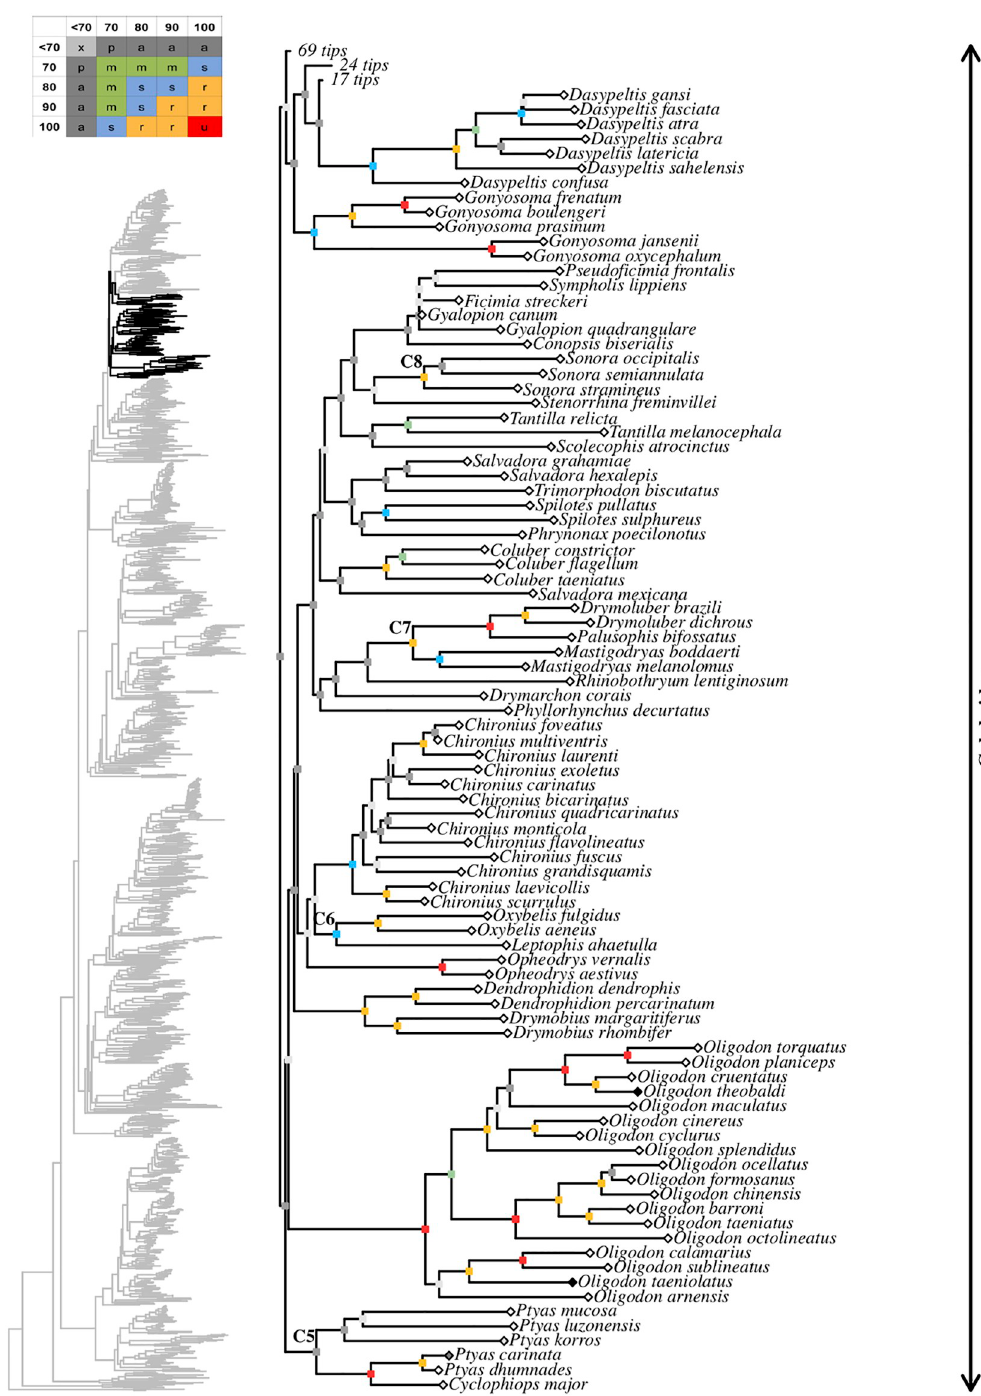
Fig 20. Maximum likelihood species-level phylogeny of Colubroides (continued). Family Colubridae (continued).